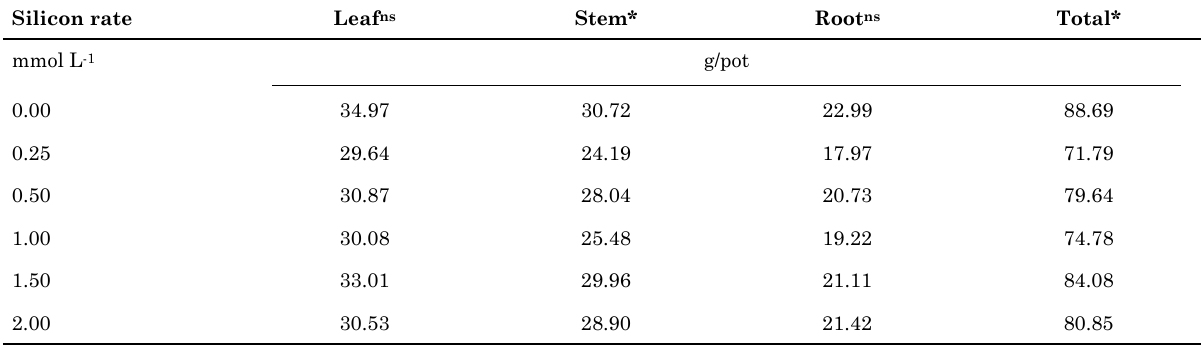
Table 1. Dry matter production of maize plants under As stress and Si application rates Silicon rate